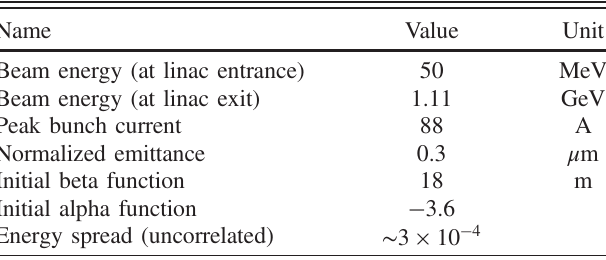
TABLE II. Initial beam parameters for the linac-arc example